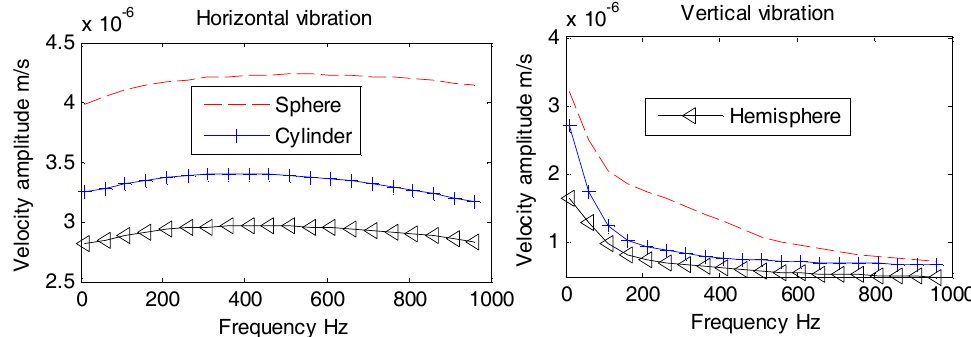
Figure 17. Vibration velocity amplitudes of the OBSs with different shapes under incident angle of 10°.